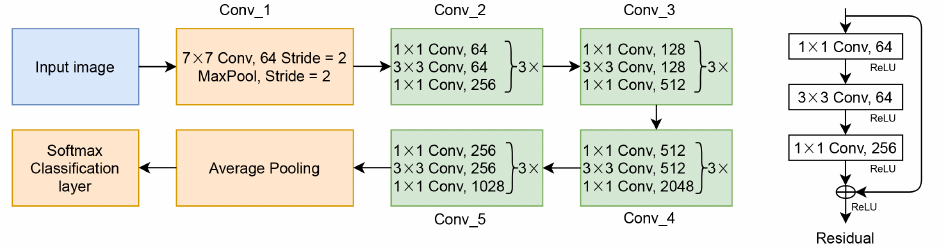
Figure 3. The basic architecture of